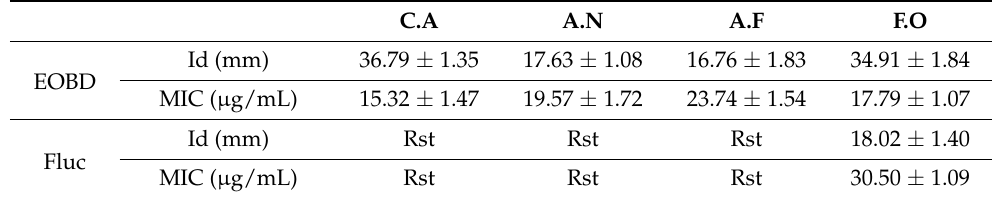
Table 4. The antifungal effect of EOBD on the basis of the inhibition on solid medium and minimal inhibitory concentration assays.